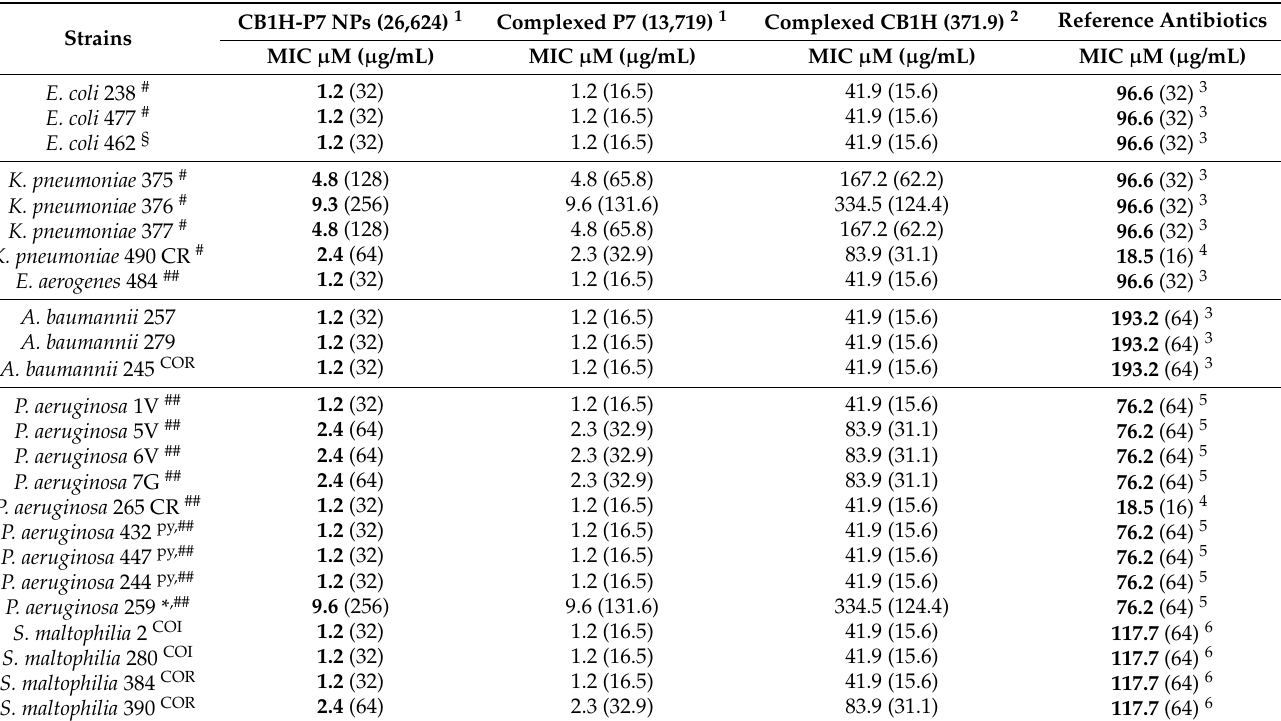
Table 6. MIC values of CB1H-P7 NPs and those of P7 and CB1H in the complex against bacteria of Gram-negative species, obtained from experiments carried out in triplicate, and those of reference antibiotics expressed as µ M and µ